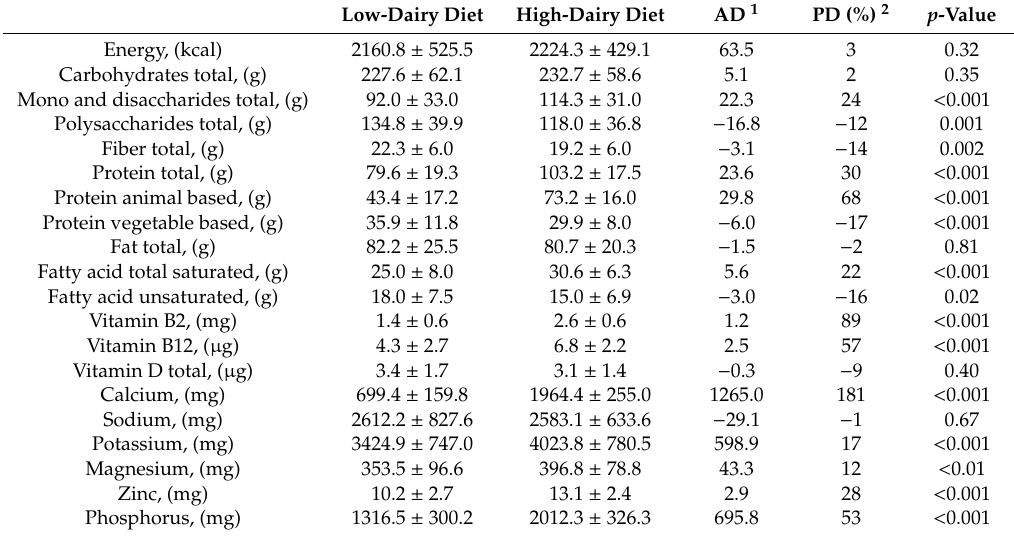
Table 2. Food components during the high- and low-dairy